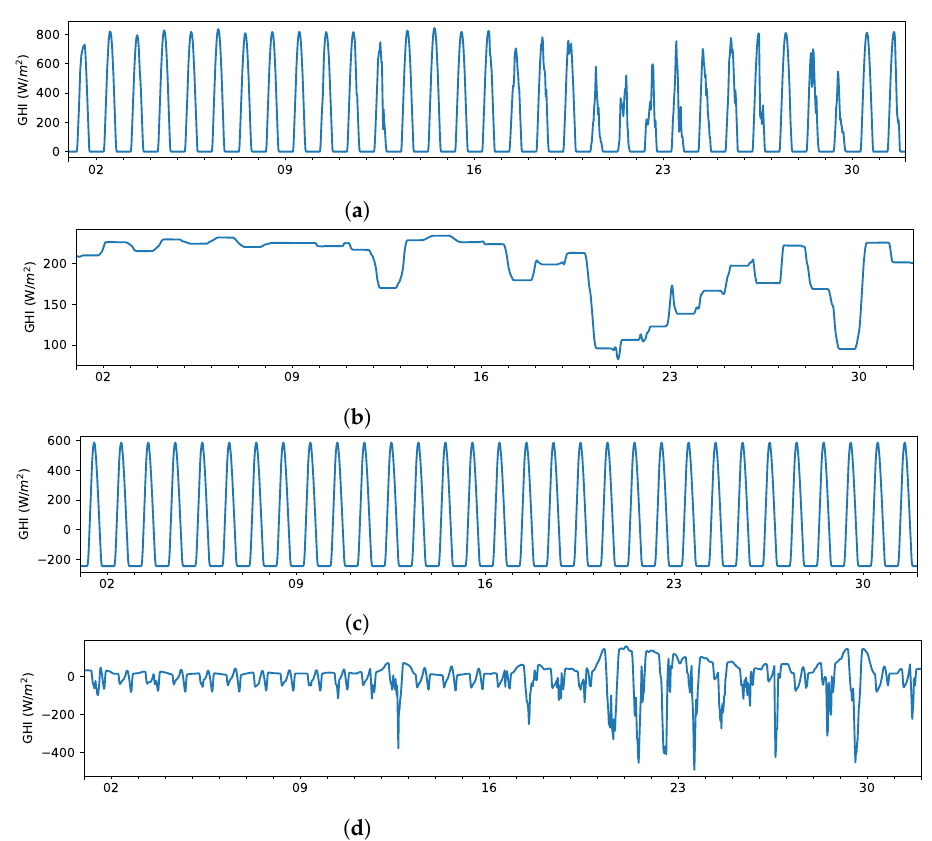
Figure 5. GHI time series decomposition. ( a ) Observed values. ( b ) Trend component. ( c ) Seasonal component. ( d ) Residual